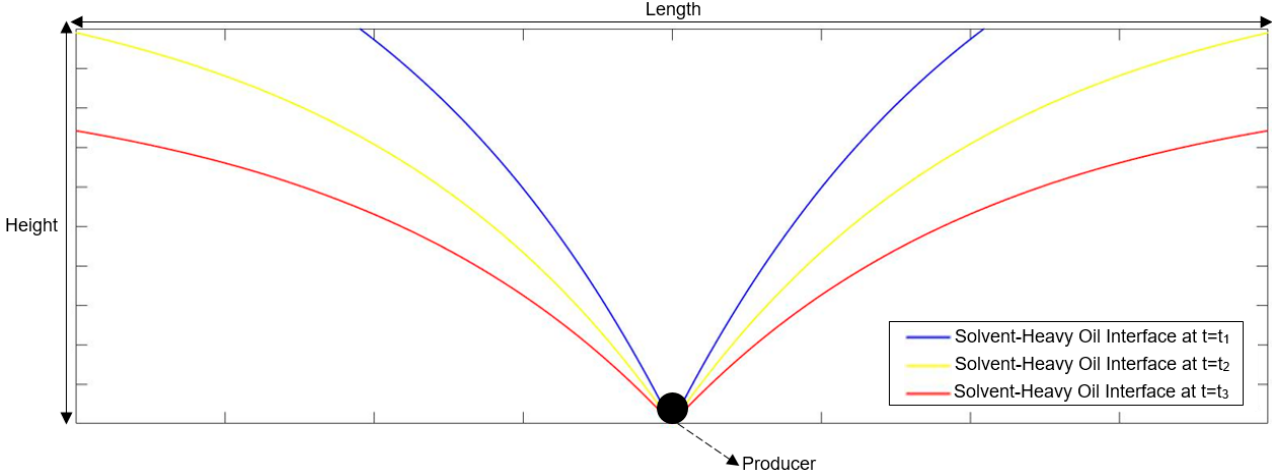
Figure 2. Convex exponential propagation of solvent chamber throughout the spreading and falling stages.